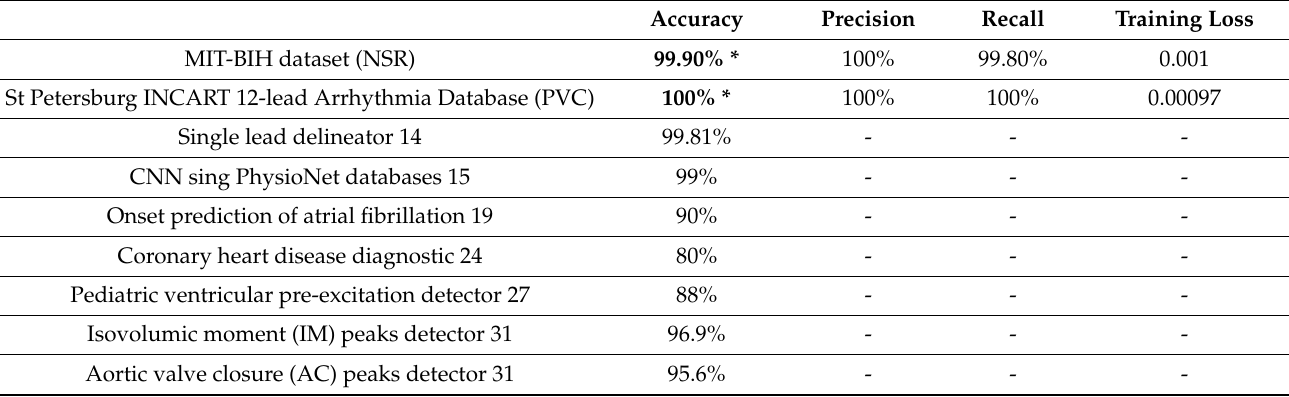
Table 3. Performance comparison with other